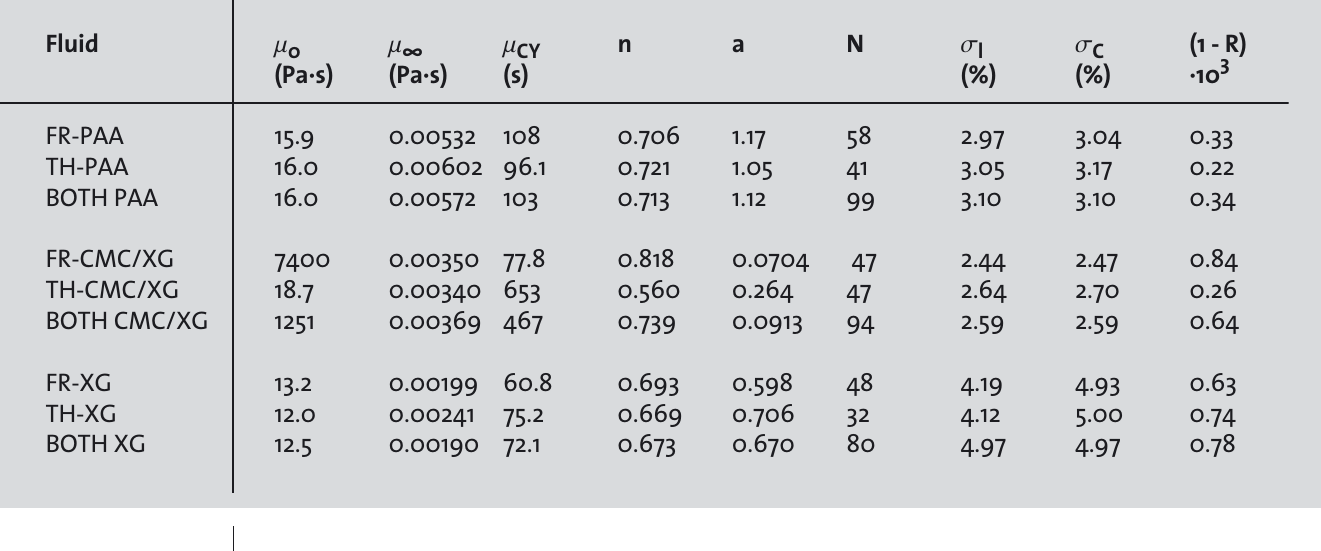
Table 1: Carreau-Yasuda model parameters and correlation